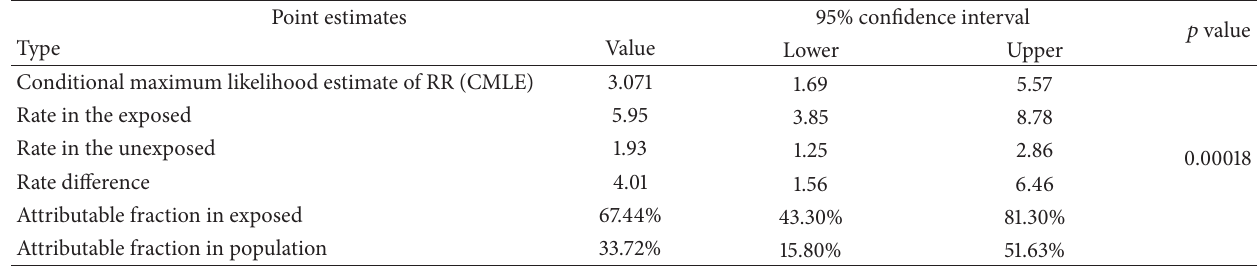
Table 6: Efficacy of Epley’s maneuver based on person time among benign paroxysmal positional vertigo patients.